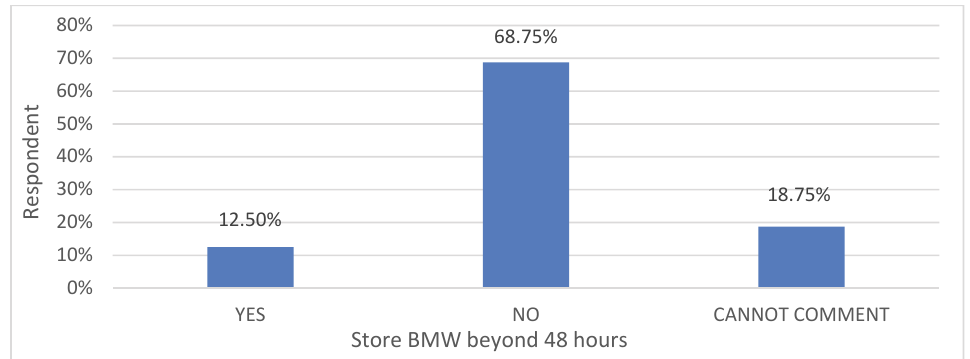
Fig. 5. Storage of Biomedical waste beyond 48 hours